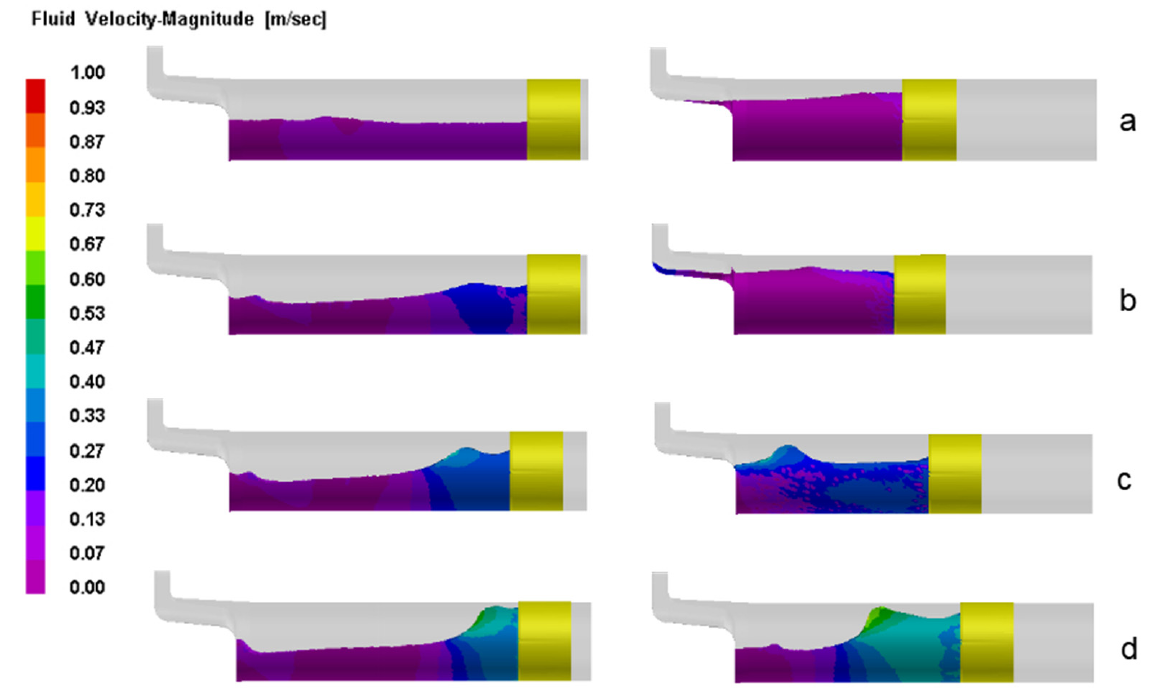
Figure 6. Simulation results of the liquid wave and air entrainment in a chamber during the slow stage of injection: ( a ) piston velocity was 0.1 m/s, ( b ) piston velocity was 0.2 m/s, ( c ) piston velocity was 0.3 m/s and ( d ) piston velocity was 0.4 m/s.